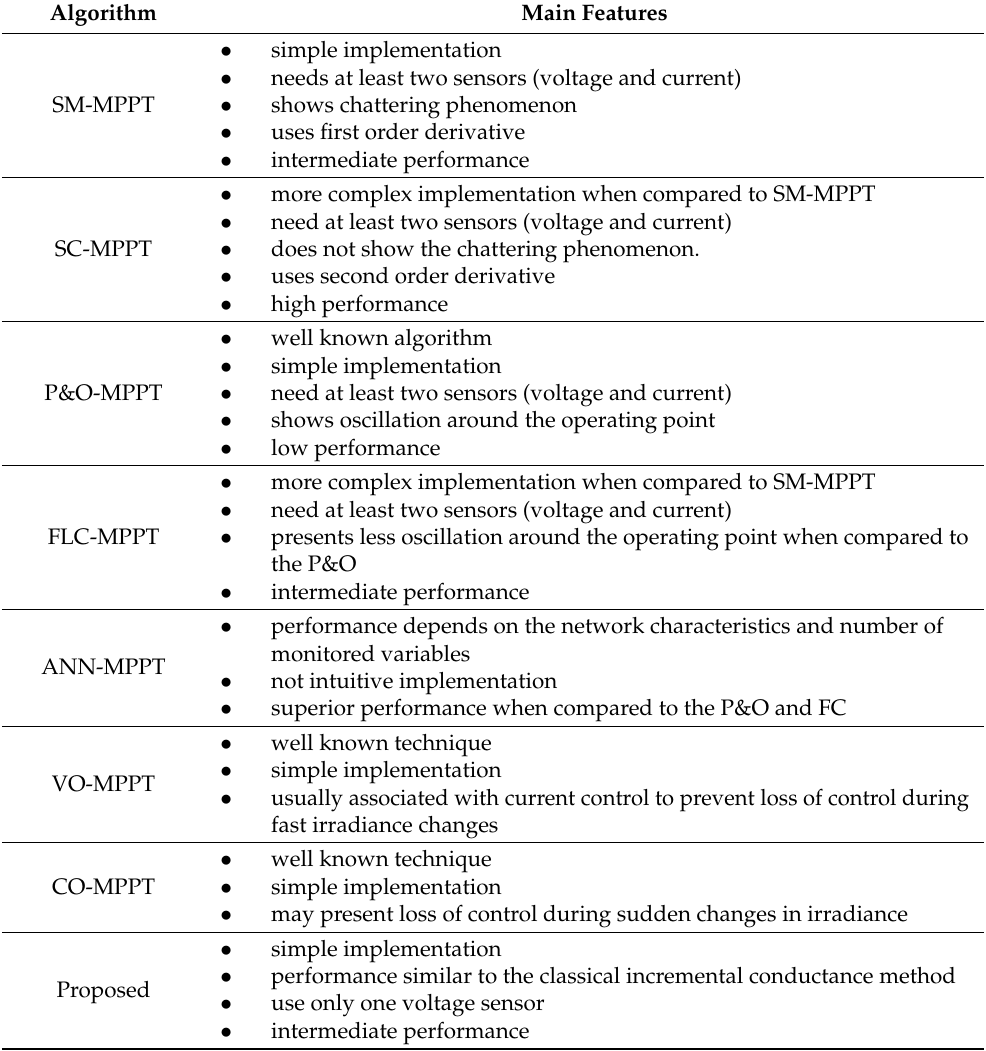
Table 8. Comparison between the proposed algorithm with other ones previously published in the